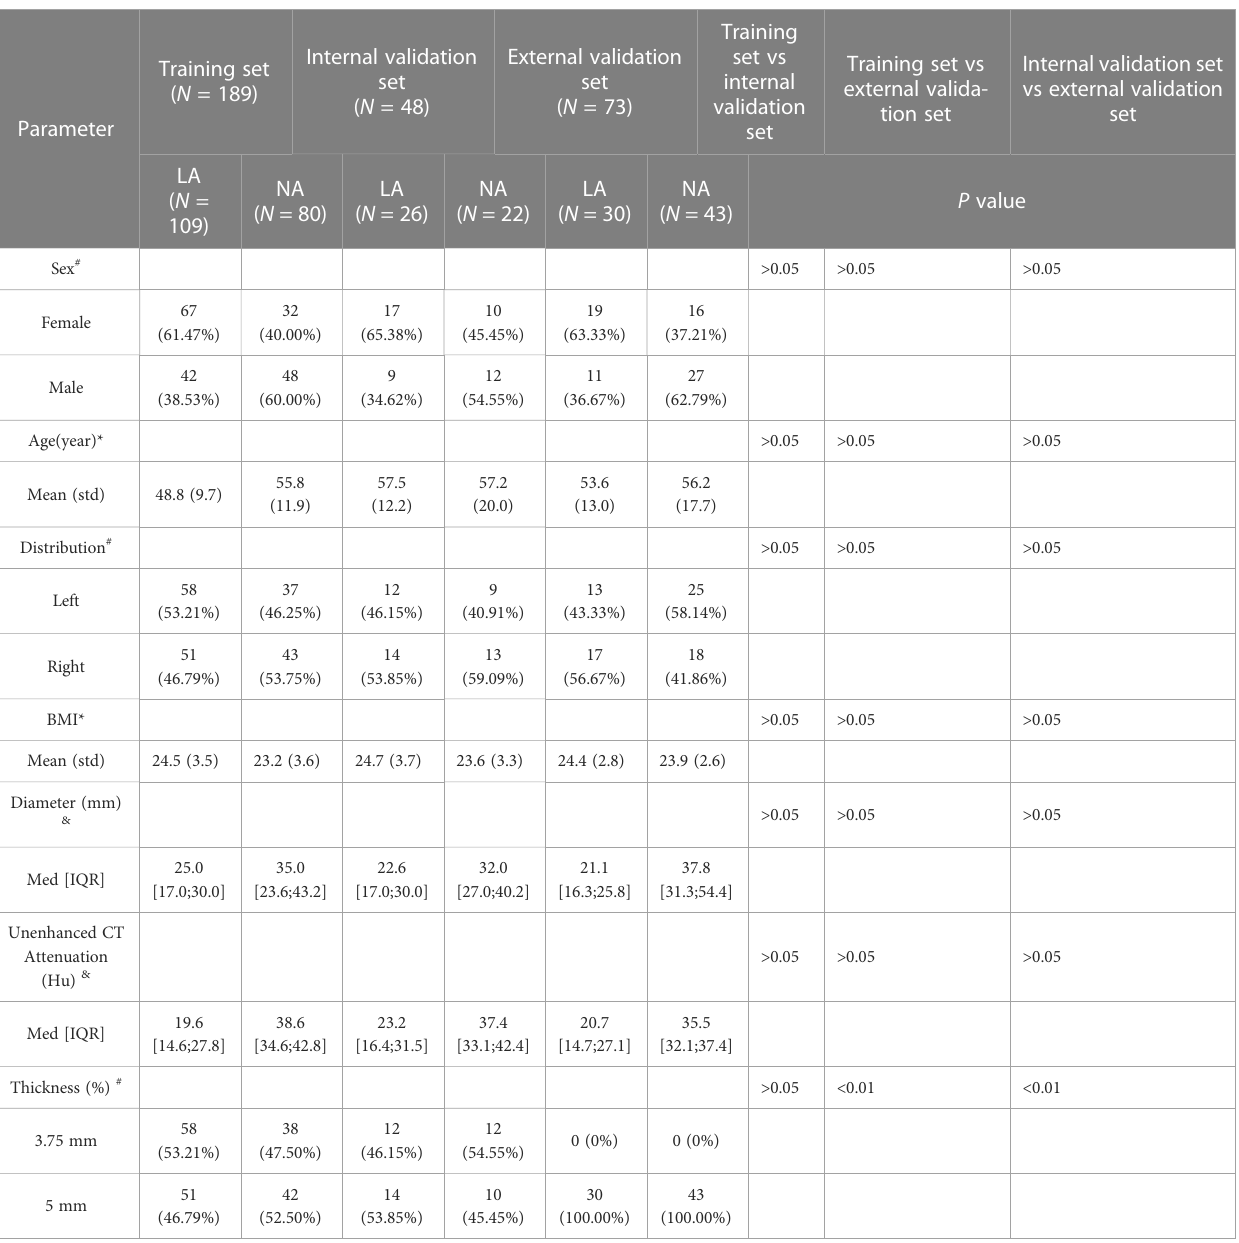
TABLE 1 Baseline data of patients in training, internal validation, and external validation